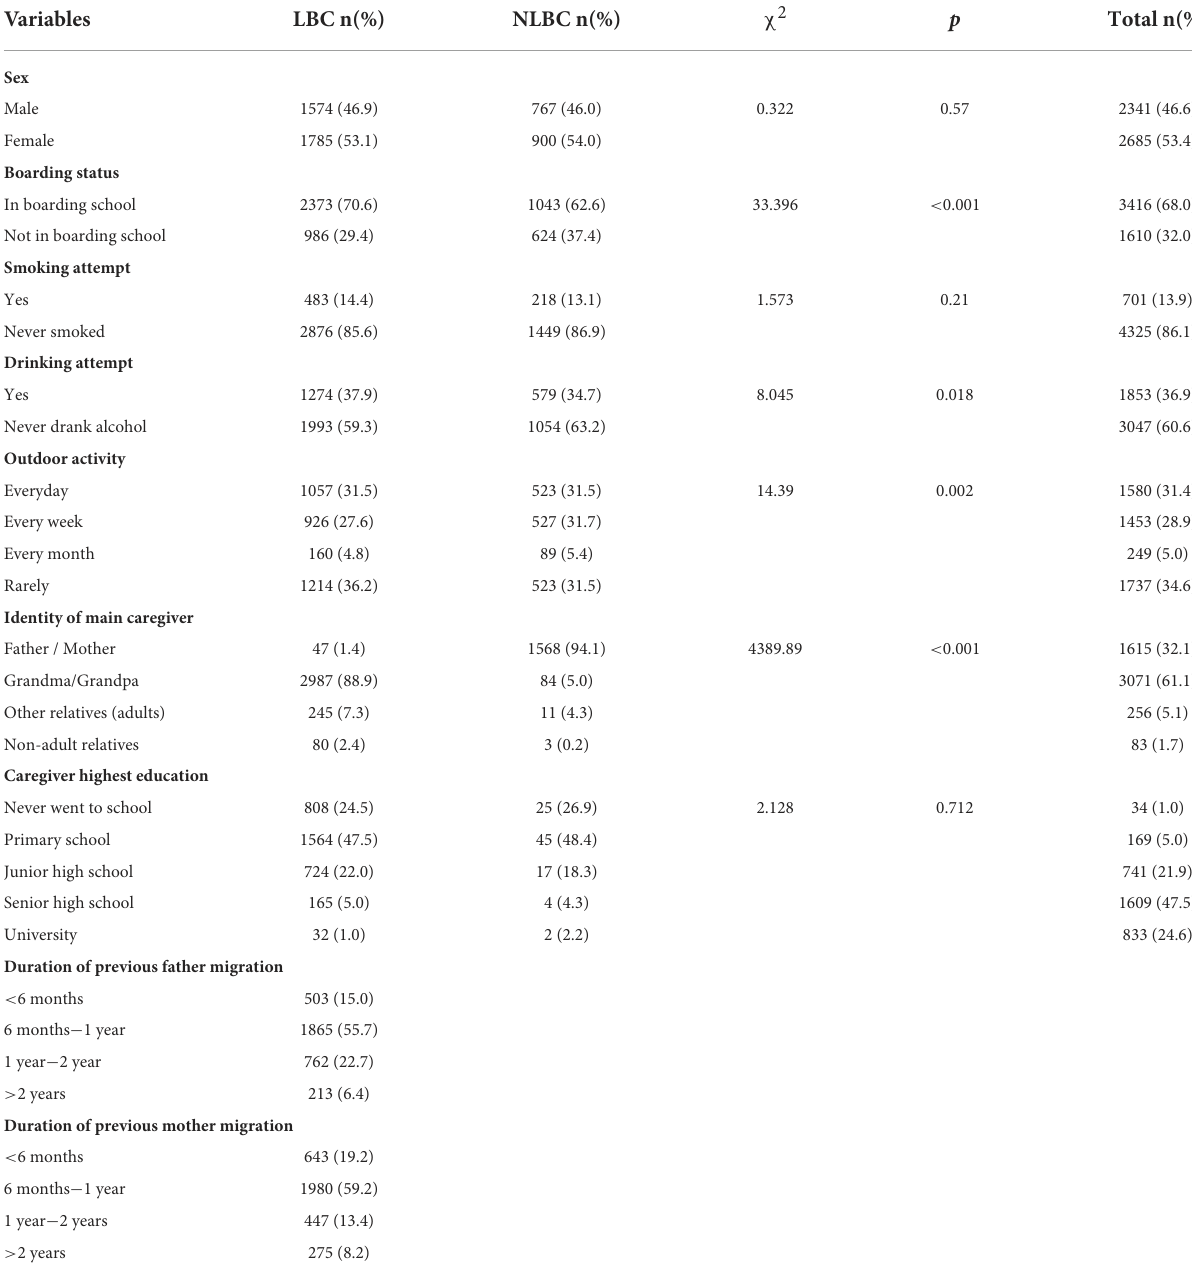
TABLE 1 Comparison of demographic characteristics, smoking attempt, previous alcohol use in LBC ( n = 3359) and NLBC ( n =